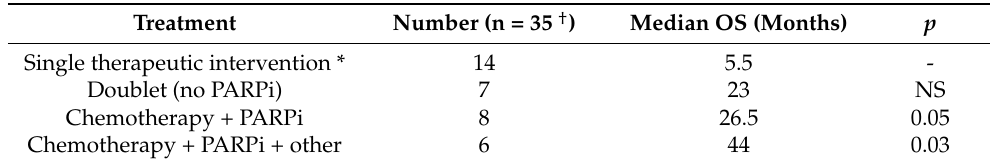
Table 3. Median OS in relation to number of treatment modalities received for BM. NB: 13/14 those receiving PARPi for BM were fi rst platinum-sensitive relapse, compared with 5/21 who did not re- ceive PARPi for BM at fi rst relapse.